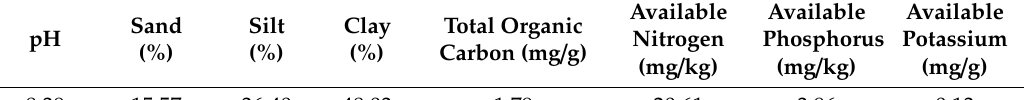
Table A1. The physicochemical properties of the sediment used in the incubation experiment.